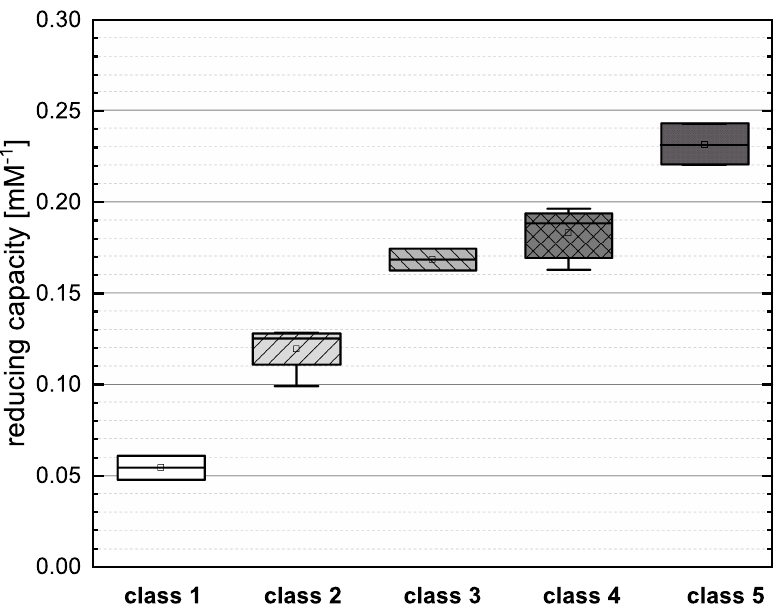
Figure 4. Boxplot of the mean values of the reducing capacity for the new classification of flavonoids as shown in Table 2, investigated in the FC assay. Error bars represent range within standard errors (1.5 interquartile